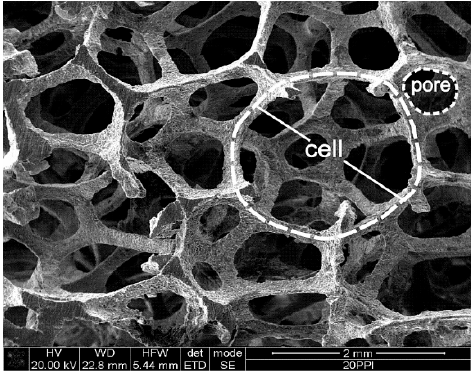
Figure 1. Example of a pore and a cell in a microscopic image of a 20 PPI foam skeleton.